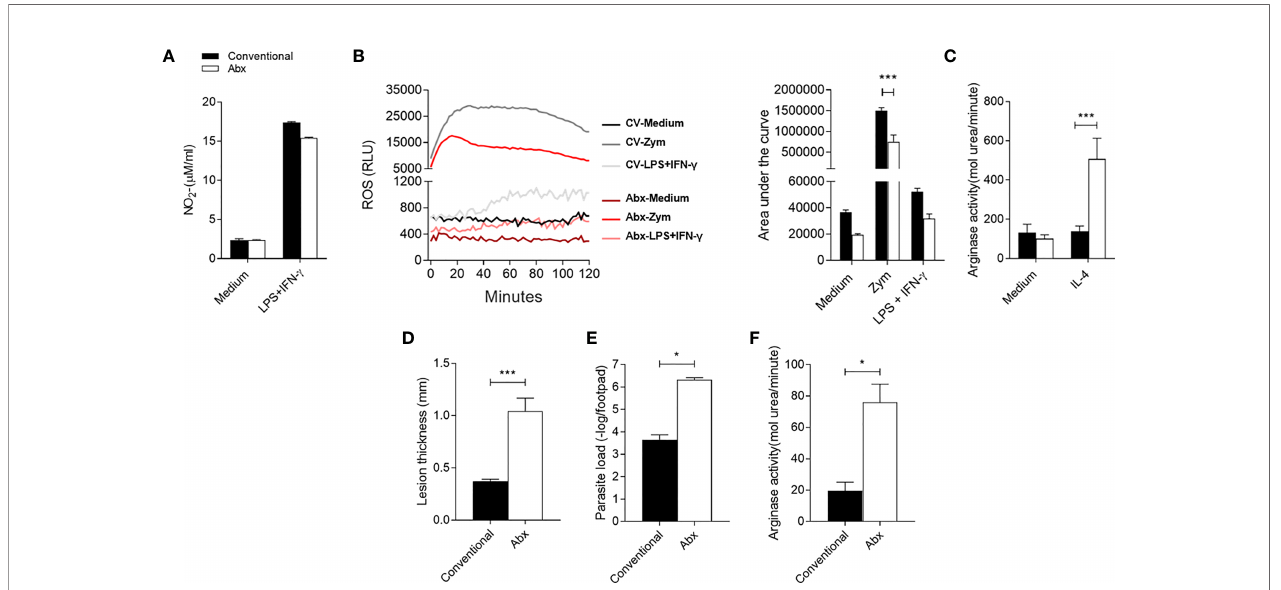
FIGURE 7 | Dysbiosis alters in-vitro macrophage activation status and impairs control of infection in vivo . (A) Nitrite production in the supernatant of BMDM by the Griess method, after 48h of stimulation with LPS+IFN- g . (B) Production of reactive oxygen species (ROS) by BMDM unstimulated or stimulated with Zymosan (Zym) or with LPS+IFN- g for 2h. (C) Measurement of arginase activity in BMDM after 48h of stimulation with IL-4. (D) Lesion thickness in footpad 6 weeks post infection. (E) Quanti fi cation of parasite load by limiting dilution of the infected footpads 6 weeks post infection. (F) Arginase activity in footpad lysate 6 weeks after infection. *, *** indicates statistical difference between the two groups at the same time point using two-way ANOVA and post-Bonferroni test (p < 0.05; p < 0.001). Results are representative of three independent experiments. Three to 5 animals per